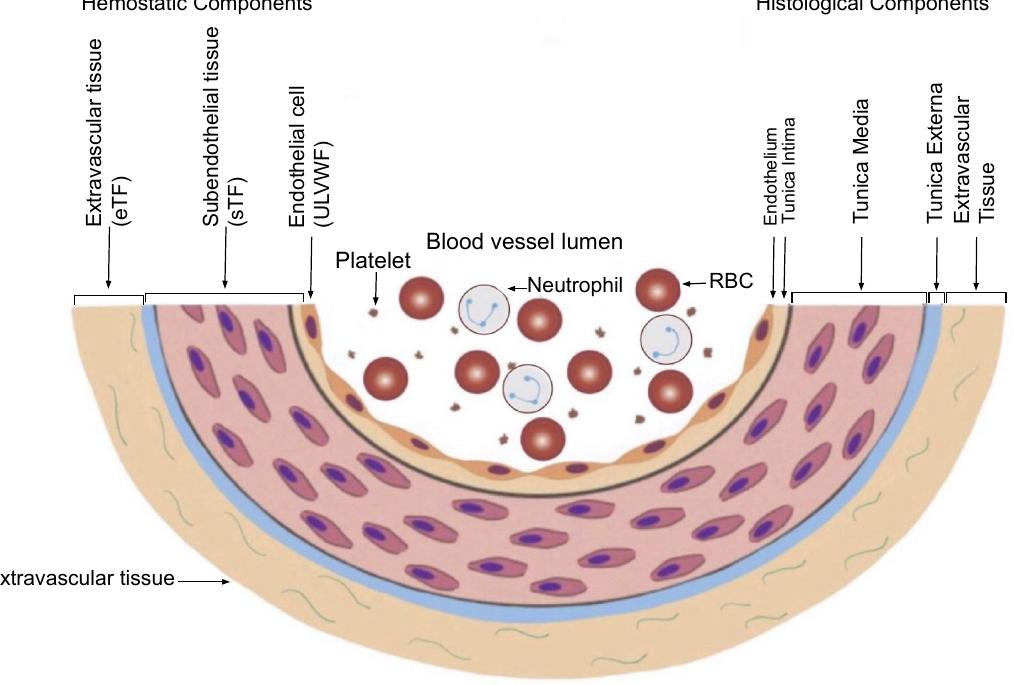
Figure 3. Schematic illustration of cross section of blood-vessel histology and hemostatic components (reproduced and modified with permission from Chang JC. Clin Appl Thromb Hemost 2019 January–December; 25:1076029619887437). The blood-vessel wall is the site of hemostasis (coagulation)